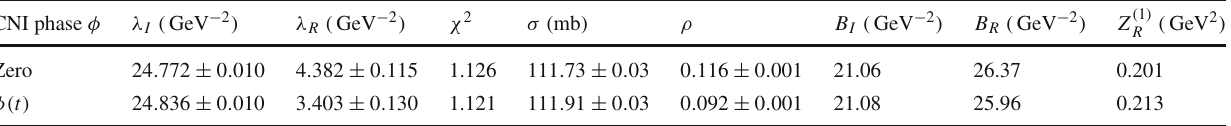
Table 4 Values of parameters λ I and λ R and of χ 2 (with statistical errors only) obtained specifically for the 138 points of Set I, with all other quantities ( α K , β K , γ K ) kept as given in Table 1 and used in Table 2. We here give the values for fitting with Coulomb interference phase φ put as zero, and for phase calculated as described before [4]. The χ 2 values may be compared with χ 2 = 1 . 455 (with CNI phase zero) given in Table 2 and χ 2 = 2 . 144 with CNI phase calculated with